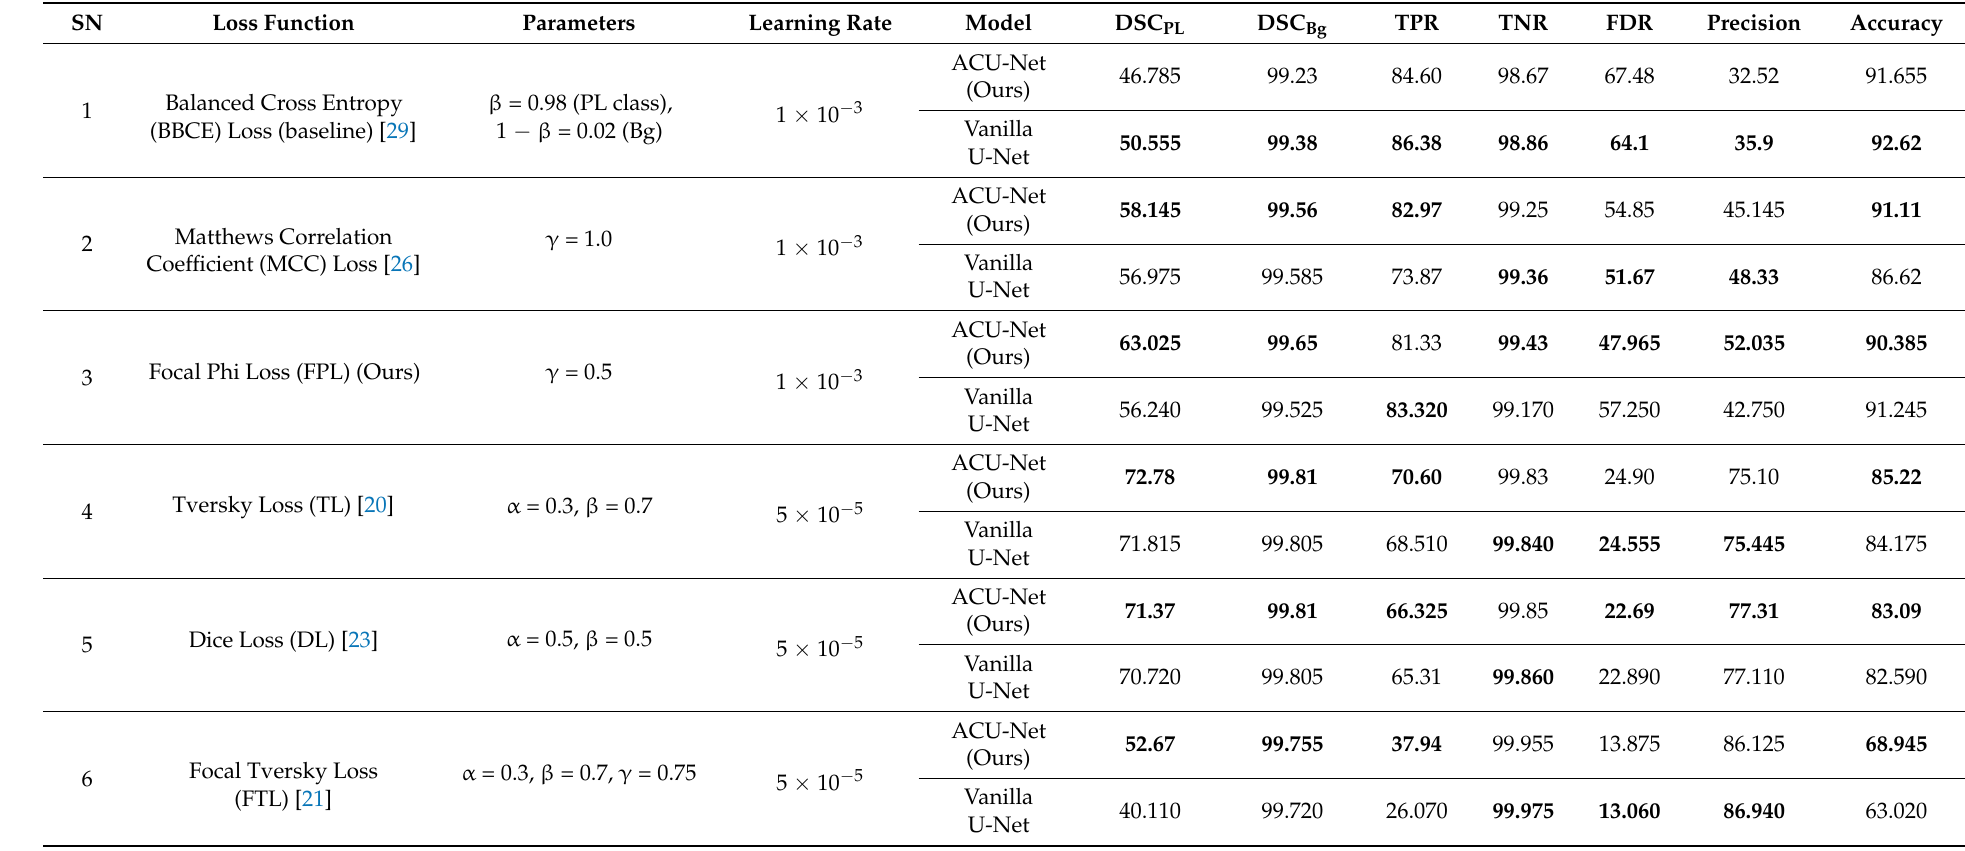
Table 5. Experimental results comparison of the proposed ACU-Net and vanilla U-Net model with various loss functions on Mendeley PL validation dataset with 80 images.